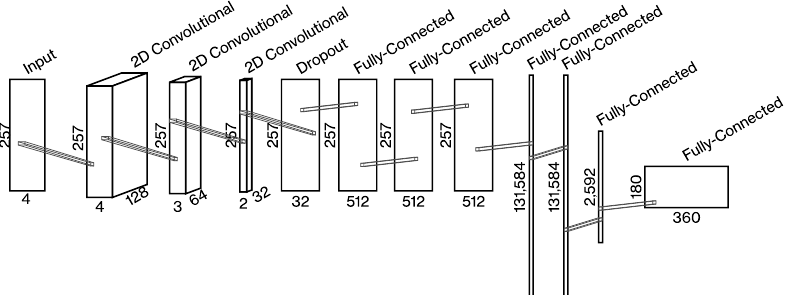
Figure 3. A schematic diagram of the CNN architecture, used for the experimental